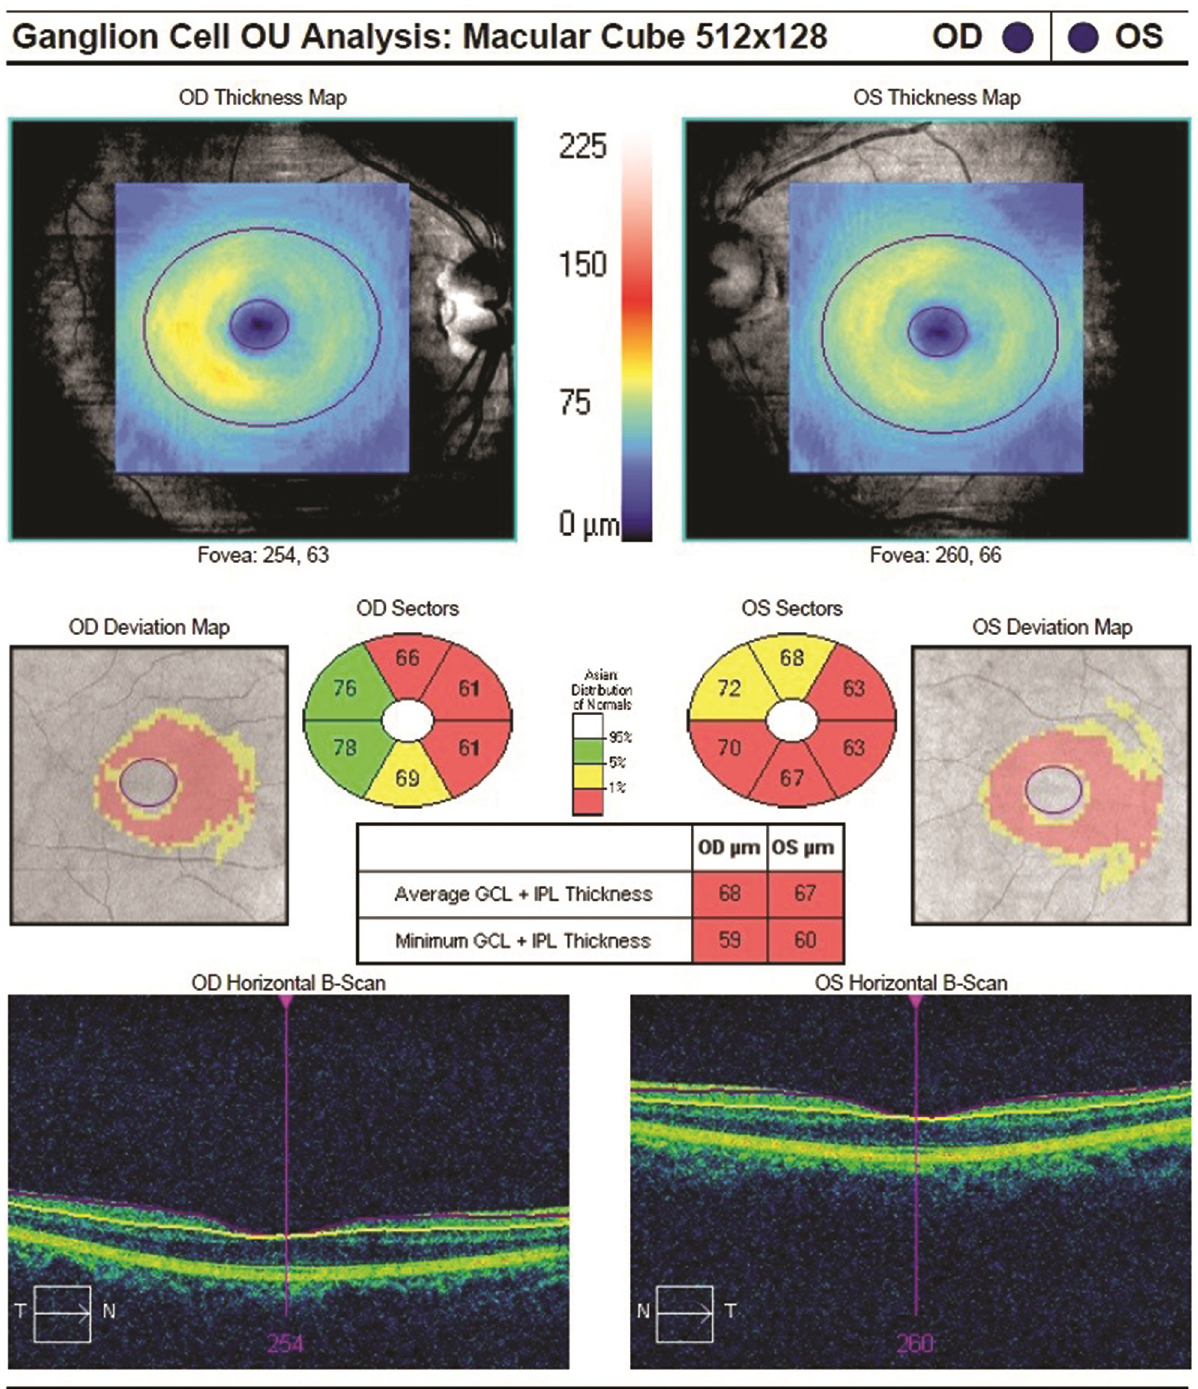
Fig 1. The Cirrus HD-OCT result of GC-IPL thickness in a patient with AD. OD: right eye, OS: left eye. https://doi.org/10.1371/journal.pone.0224180.g001 for age using the Kruskal-Wallis and Mann-Whitney tests, for gender using the chi-square test and for difference in OCT measurements using the analysis of covariance (ANCOVA) test.